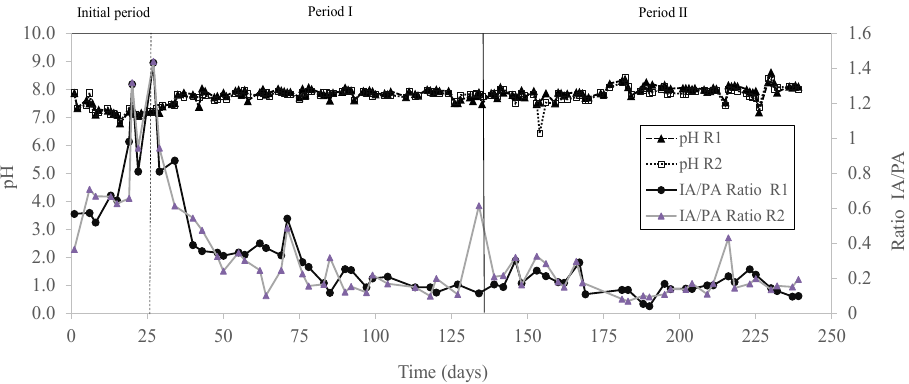
Figure 1. Experimental set-up of an anerobic reactor for the AD experiments . The arrows indicate the direction of the flows. The semi-continuous co-digestion was performed for 240 days. The reactors were in- itially filled with 5 L of inoculum. After that, manual feeding of the reactors was per- formed once per day, every weekday. Prior to each feeding, a volume equal to the feeding volume was removed to maintain a constant reactor volume. Initially, an organic loading rate (OLR) of 1.04 g VS L − 1 d − 1 and a hydraulic retention time (HRT) of 25 days were ap- plied in both reactors (initial period). In this initial period (0–26 days), R1 was fed with SM alone; whereas R2 was fed with a mixture of SM and AP in a feed VS ratio of 85.0% SM and 15.0% AP. This percentage was used based on a previous work that investigated the influence of the percentage of AP on anaerobic co-digestion of AP and SM, following a central composite design, and obtaining the highest methane yield with a percentage of AP in the mixture of 15% [12]. Since a progressive destabilization of both reactors occurred during the initial period (Figure 2), the applied OLR was decreased to 0.78 g VS L − 1 d − 1 , and the HRT was increased to 33 days, maintaining these conditions during the rest of the experiment.